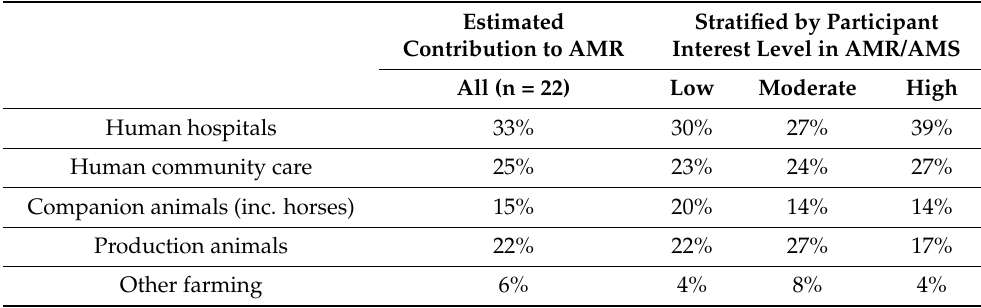
Table A1. Participant’s estimates of the contribution made by different sectors to the overall problem of AMR in